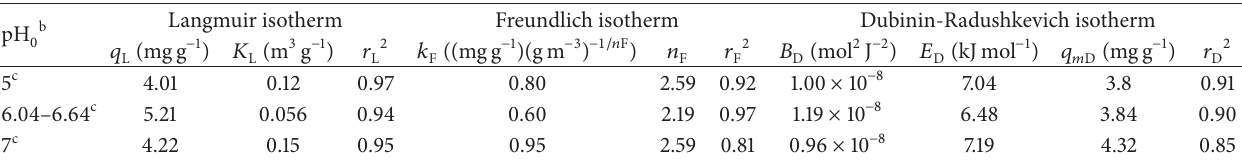
Table 2: Values of isotherm parameters and correlation coefficients ( 𝑟 2 ) a with different initial pH values. pH 0 b